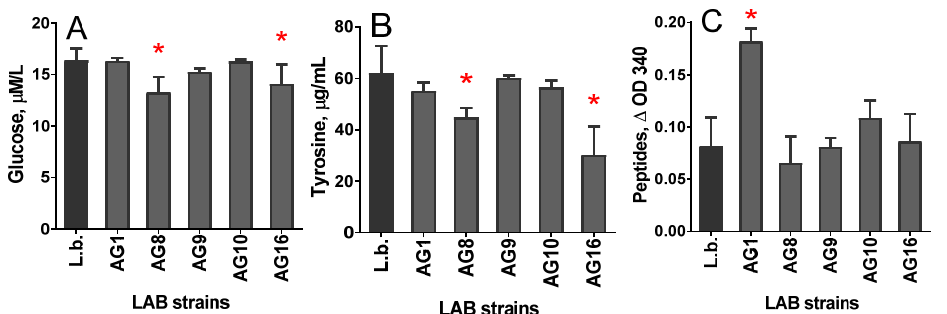
Figure 1. Chemical composition of protein-free extract of skim milk fermented by different strains of LAB ( A ) concentration of dextrose, ( B ) phenolic compounds (by tyrosine), ( C ) free peptides, reaction with OPA-reagent). L. b.— L. bulgaricus , AG1— L. plantarum AG1, AG8— L. fermentum AG8, AG9— L. plantarum AG9, AG10— L. plantarum AG10, AG16— L. rhamnosus AG16. Asterisks indicate statistically significant differences with L. bulgaricus according to non ‐ parametric one ‐ way analysis of variance (Kruskal–Wallis) test, p < 0 . 05.